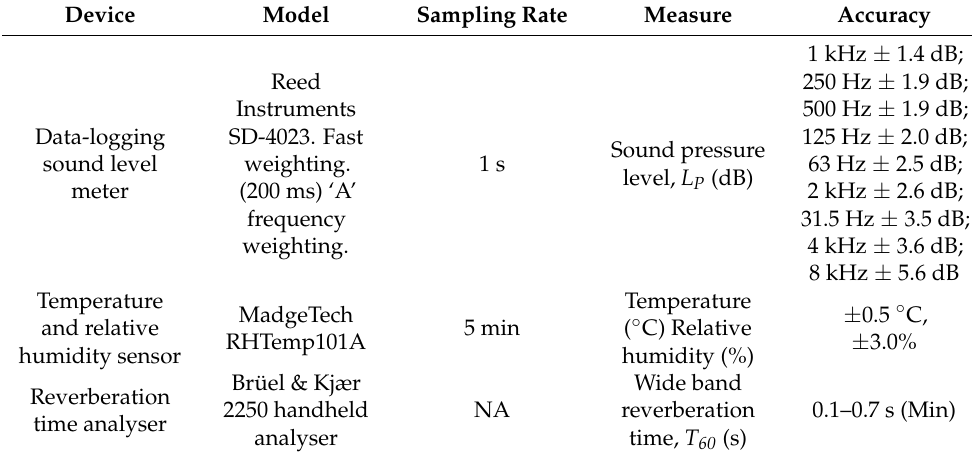
Table 2. Environmental monitoring data logger